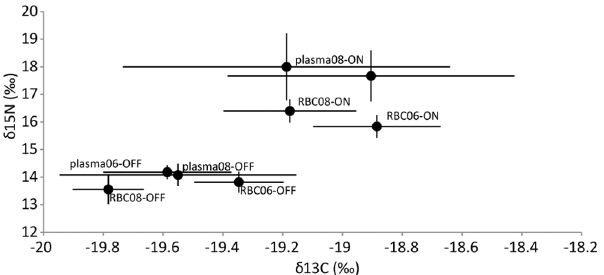
Fig 4. Mean ( ± SD) δ 15 N and δ 13 C values for plasma and red blood cell (RBC) tissues collected from adult female northern fur seals in 2006 and 2008. On-shelf foragers (ON) exclusively utilized < 200m depth and off-shelf foragers (OFF) traveled beyond the 200m isobaths to